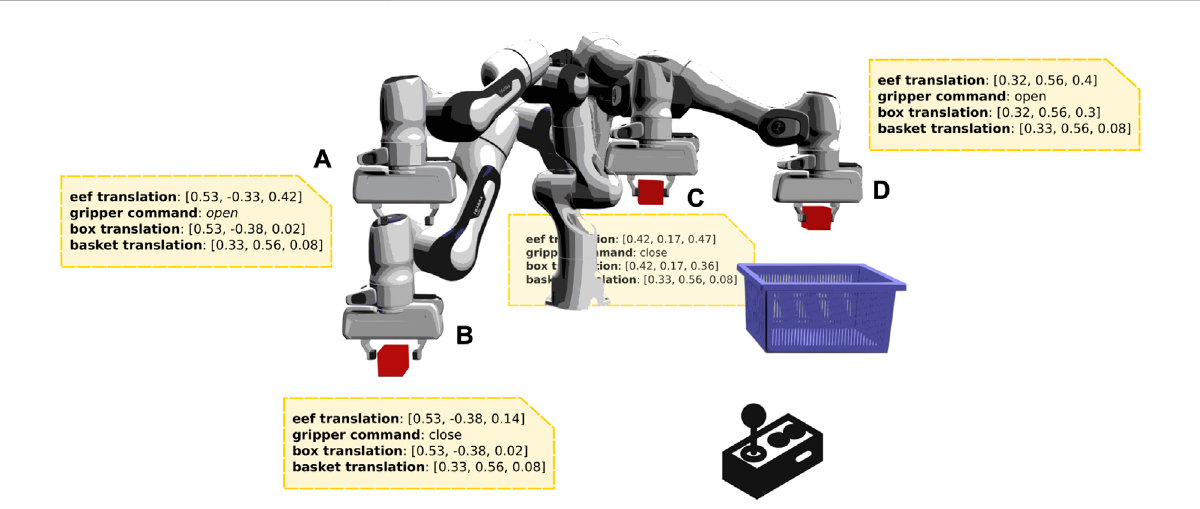
FIGURE 1 An example of a solution sketch. The end-effector of a manipulator is controlled via a joystick to solve a pick and place task. High-level information of the trajectory followed (e.g., robot and object states), consisting only of state variables, constitutes a solution sketch. As an example, the states marked (A – D) in the fi gure showcase potential points on the trajectory with corresponding state information.